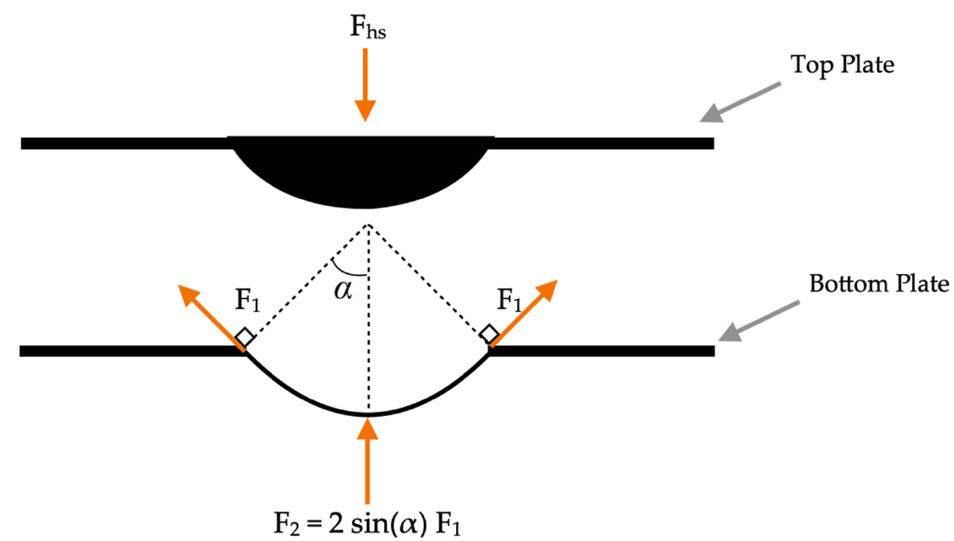
Figure 7. Energy-harvester assembly-force schematic diagram.